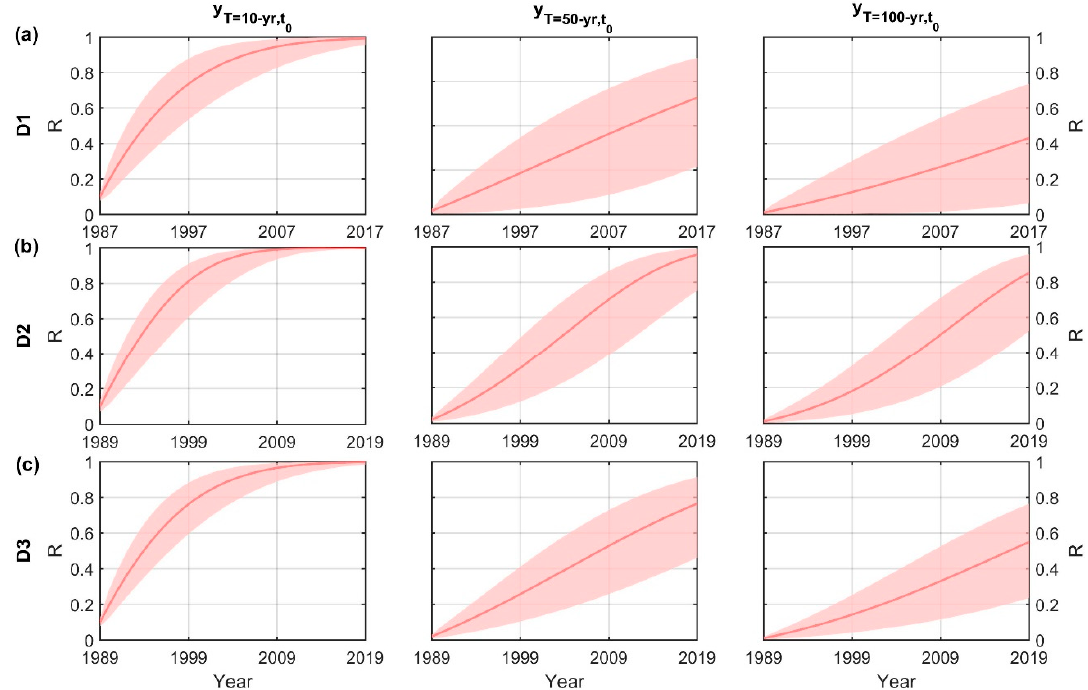
Figure 6. The point estimates of the risk of failure ( R ) (red lines) and their uncertainty estimates (shaded areas) at the three selected assessment thresholds ( y s p ) (the 10-, 50-, and 100-yr quantiles derived from the corresponding nonstationary model at the reference time t 0 = 30 years prior to the end of the observational period) for the three datasets, ( a ) D1, ( b ) D2, and ( c ) D3.